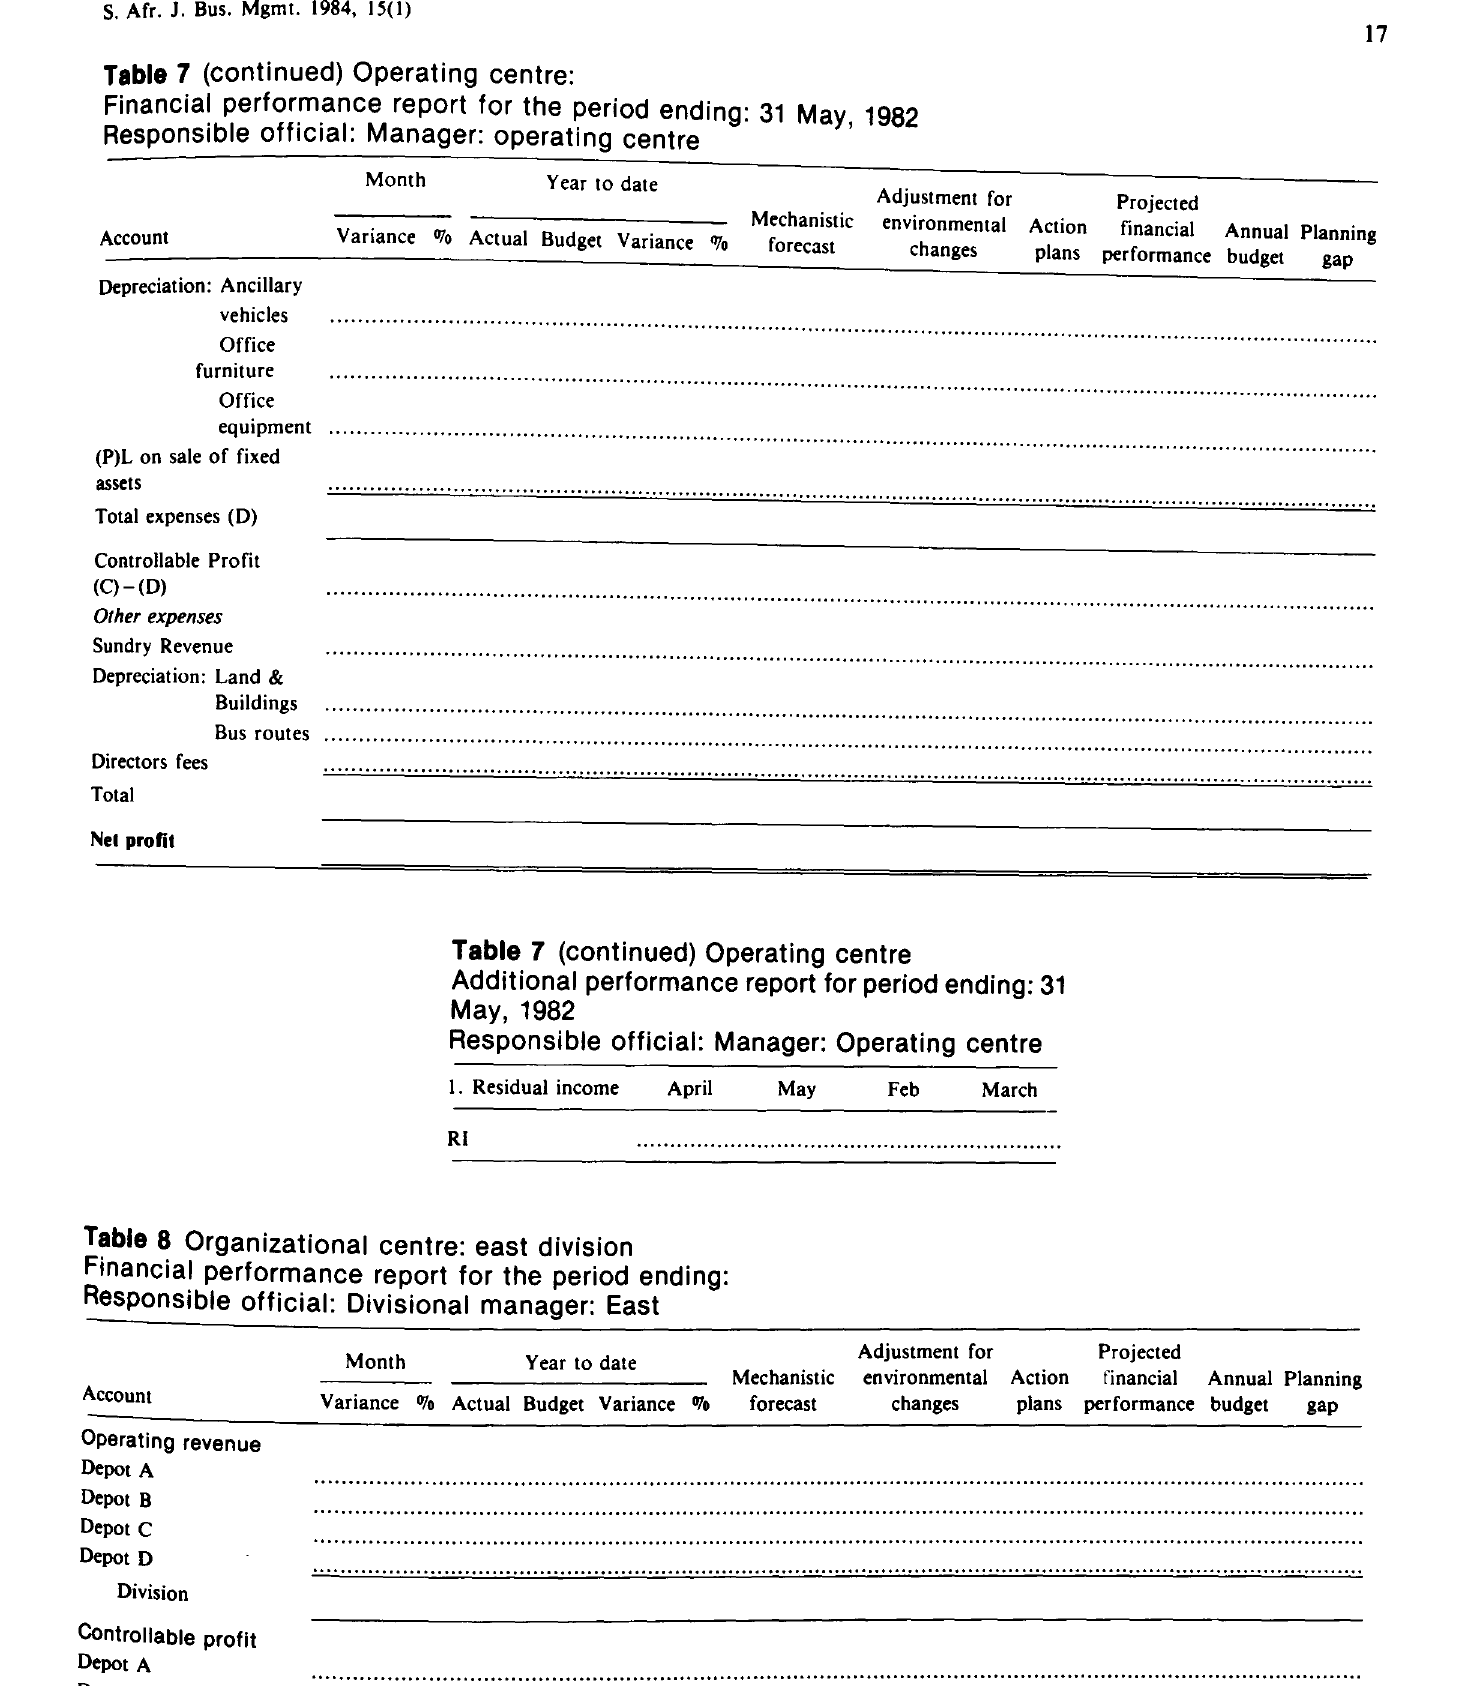
Table 8 Organizational centre: east division Financial performance report for the period